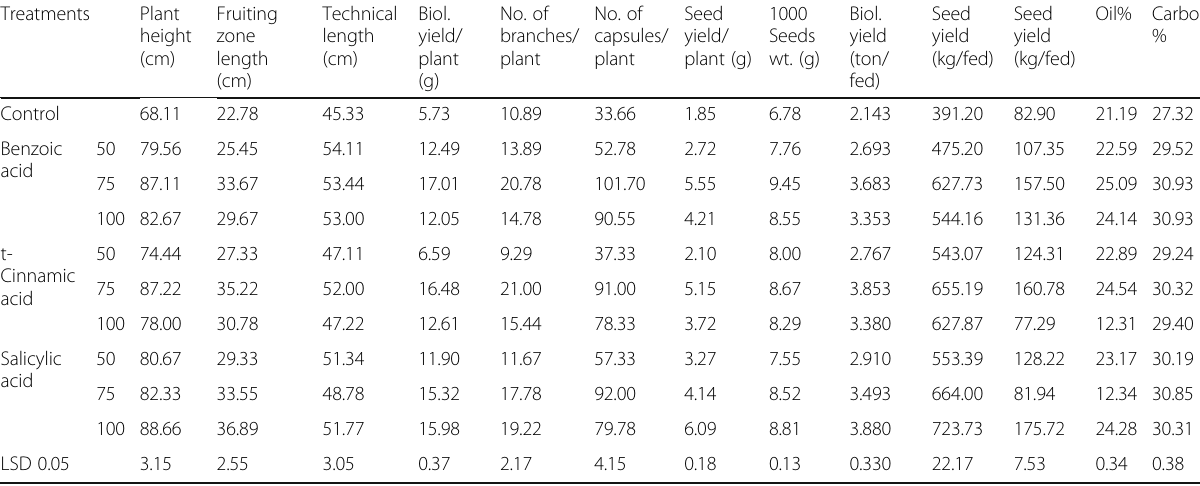
Table 19 Effect of benzoic, t-cinnamic and salicylic acids on seed yield, biological yield and its related characters of flax plants grown under sandy soil conditions (data are means of two successive seasons)